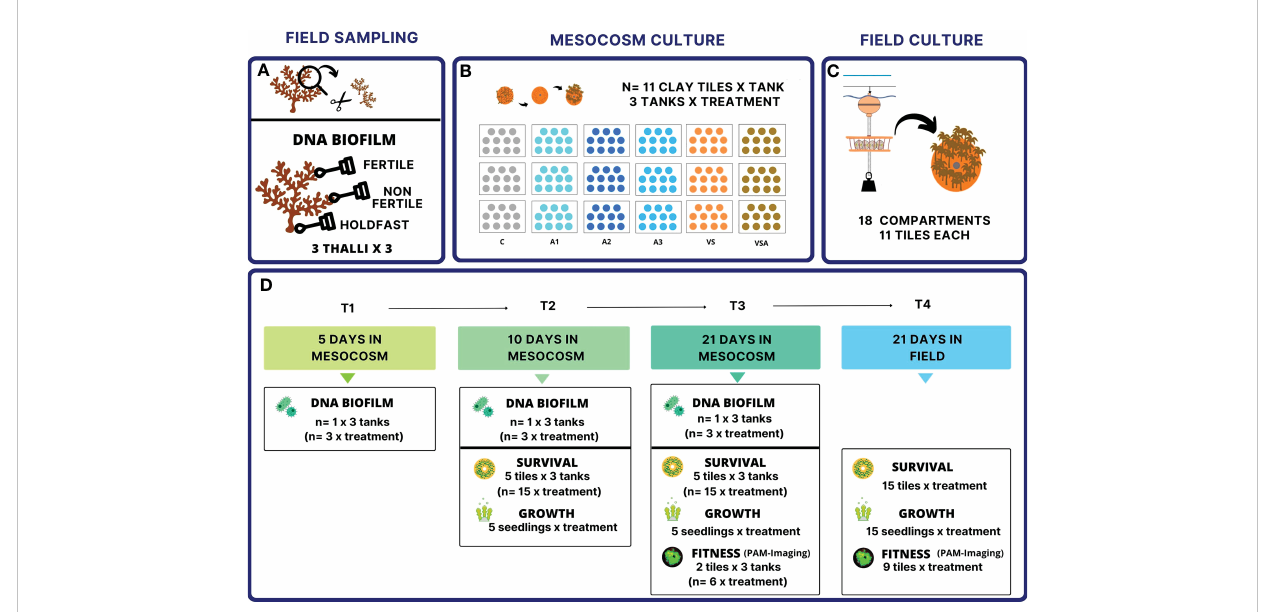
FIGURE 1 Experimental design. (A) fi eld sampling, (B) mesocosm culture, (C) fi eld culture. Culture media: A1 = 2 mL L -1 Algatron; A2 = 4.5 mL L -1 Algatron; A3 = 9 mL L -1 Algatron; C= fi ltered seawater; VS, SW enriched with Von Stosch ’ s solution; VSA, VS solution with 4.5 mL L -1 Algatron. (D) . Summary of collected data. The days (T) are counted from the release of the zygotes (Supplementary Table 1). the tiles from the same tank are considered